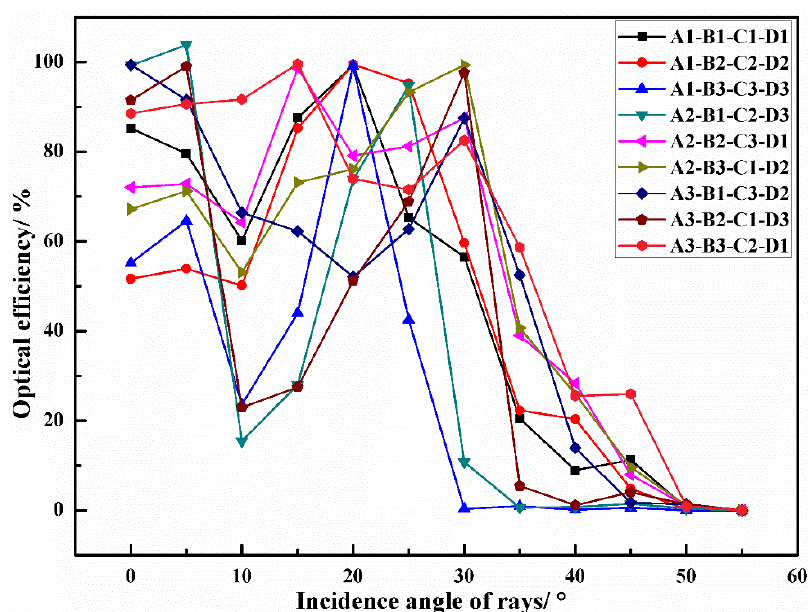
Figure 6. The relationship between the light efficiency and the incident angle under different structural settings of the optical receiver.